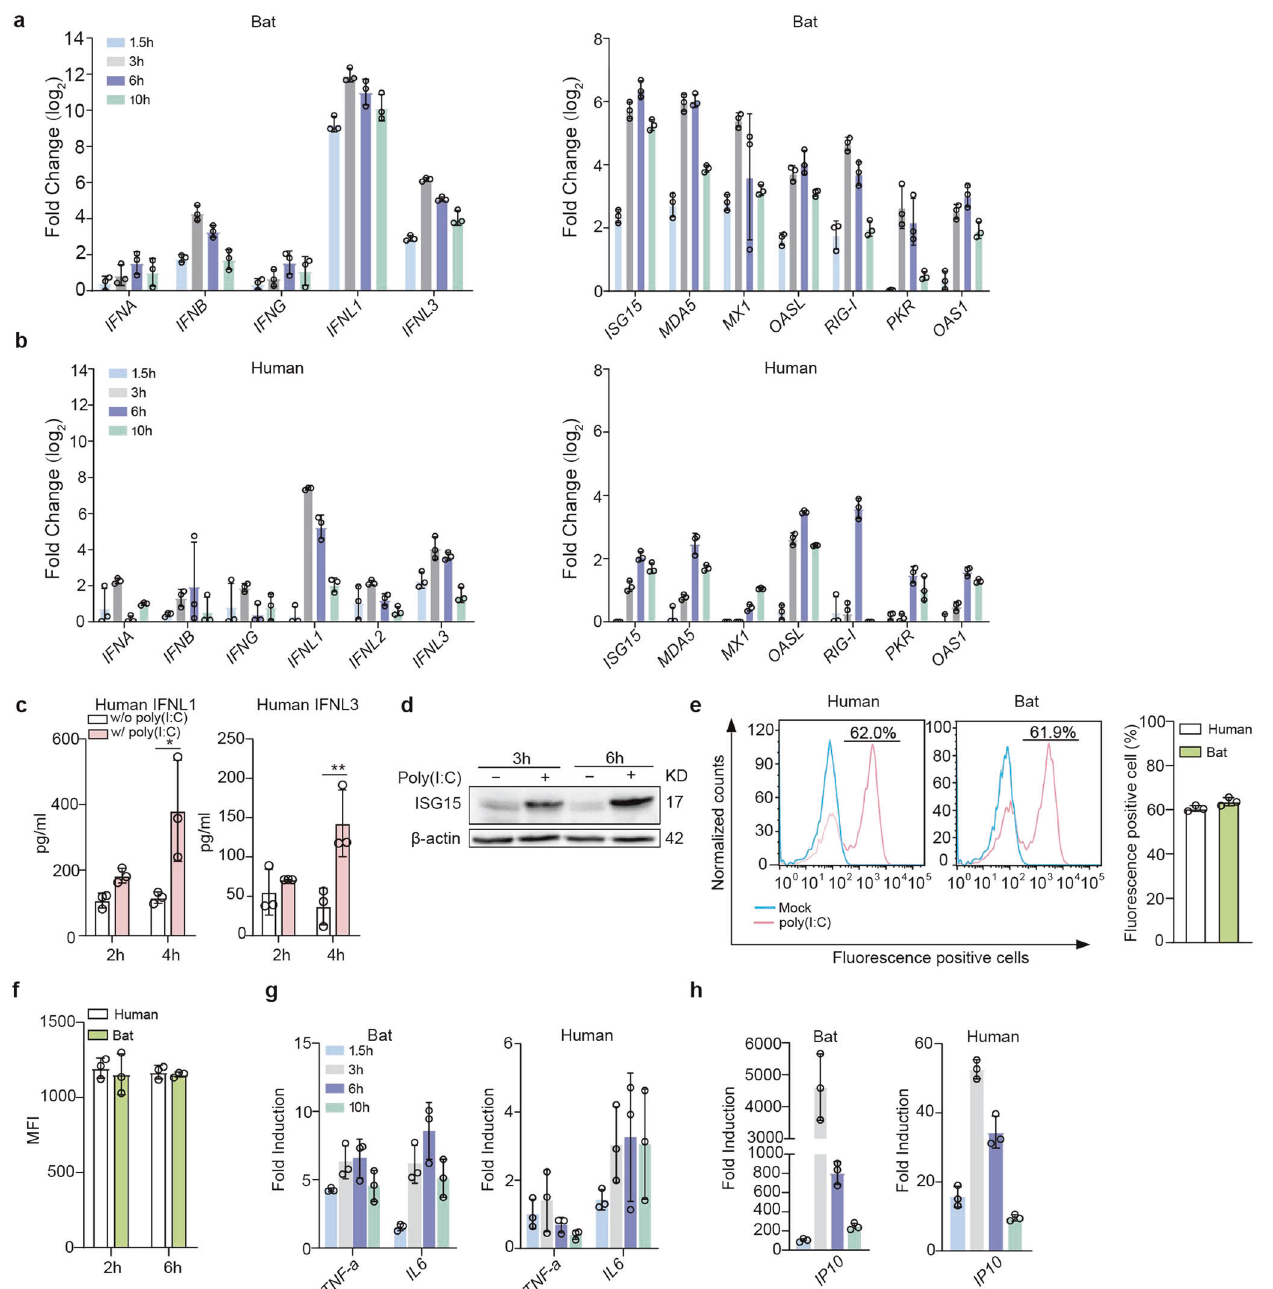
Fig. 2 Bat organoids elicited a more robust antiviral response to Poly(I:C) treatment. Bat and human intestinal organoids were sheared mechanically and treated with 10 μ g/ml Poly(I:C) or mock-treated with DMSO. a , b Induction of IFNs (left) and ISGs (right) in bat intestinal organoids ( a ) and human intestinal organoids ( b ) at the indicated hours after Poly(I:C) treatment. Results show the log2-fold change of GAPDH-normalized expression level in the treated organoids relative to mock-treated organoids. Data represent the mean and s.d. of a representative experiment in organoids from a bat and human donor, n = 3. c Culture media from the treated or mock-treated human intestinal organoids at the indicated hours were applied to ELISA to measure concentrations of IFNL1 and IFNL3. Data represent the mean and s.d. of a representative experiment in one line of human organoids, n = 3. Two-tailed unpaired Student ’ s t test. d Poly(I:C) treated or mock- treated human intestinal organoids were collected at the indicated hours post-treatment and subjected to Western blot to detect human ISG15. e , f Bat and human intestinal organoids were sheared and incubated with 10 μ g/ml Poly(I:C) Fluorescein in triplicate for 2 h and 6 h. The organoids were then dissociated and applied to fl ow cytometry to detect the percentage at 2 h post treatment ( e ) and mean fl uorescence intensity (MFI, f ) of Fluorescein-positive cells at 2 and 6 h post treatment. g , h Induction of TNF-a and IL6 ( g ) and IP10 ( h ) in bat and human intestinal organoids at the indicated hours after treatment. Results show the fold change of GAPDH-normalized expression level in Poly(I:C)- treated organoids relative to mock-treated organoids. Data represent the mean and s.d. of a representative experiment in organoids from a bat and human donor, n = 3